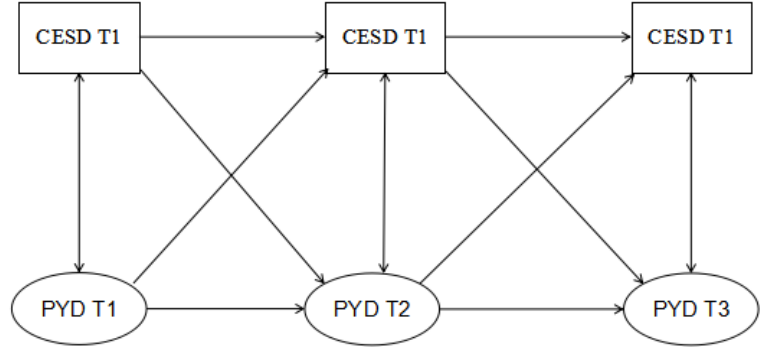
Figure 1. The hypothesized full longitudinal cross-lagged model. Cross-lagged relationship between positive youth development (PYD) and depressive symptoms across three waves; T1, Time 1 (first year); T2, Time 2 (second year), T3, Time 3 (third